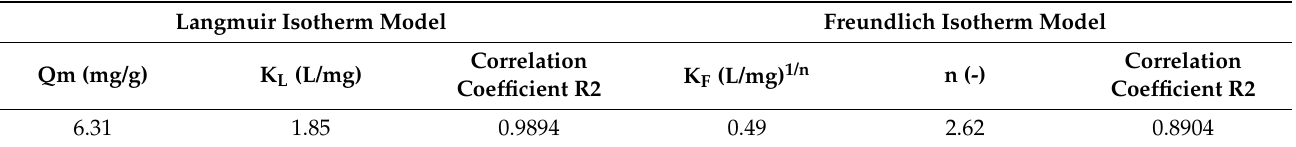
Table 2. Parameters of Langmuir and Freundlich